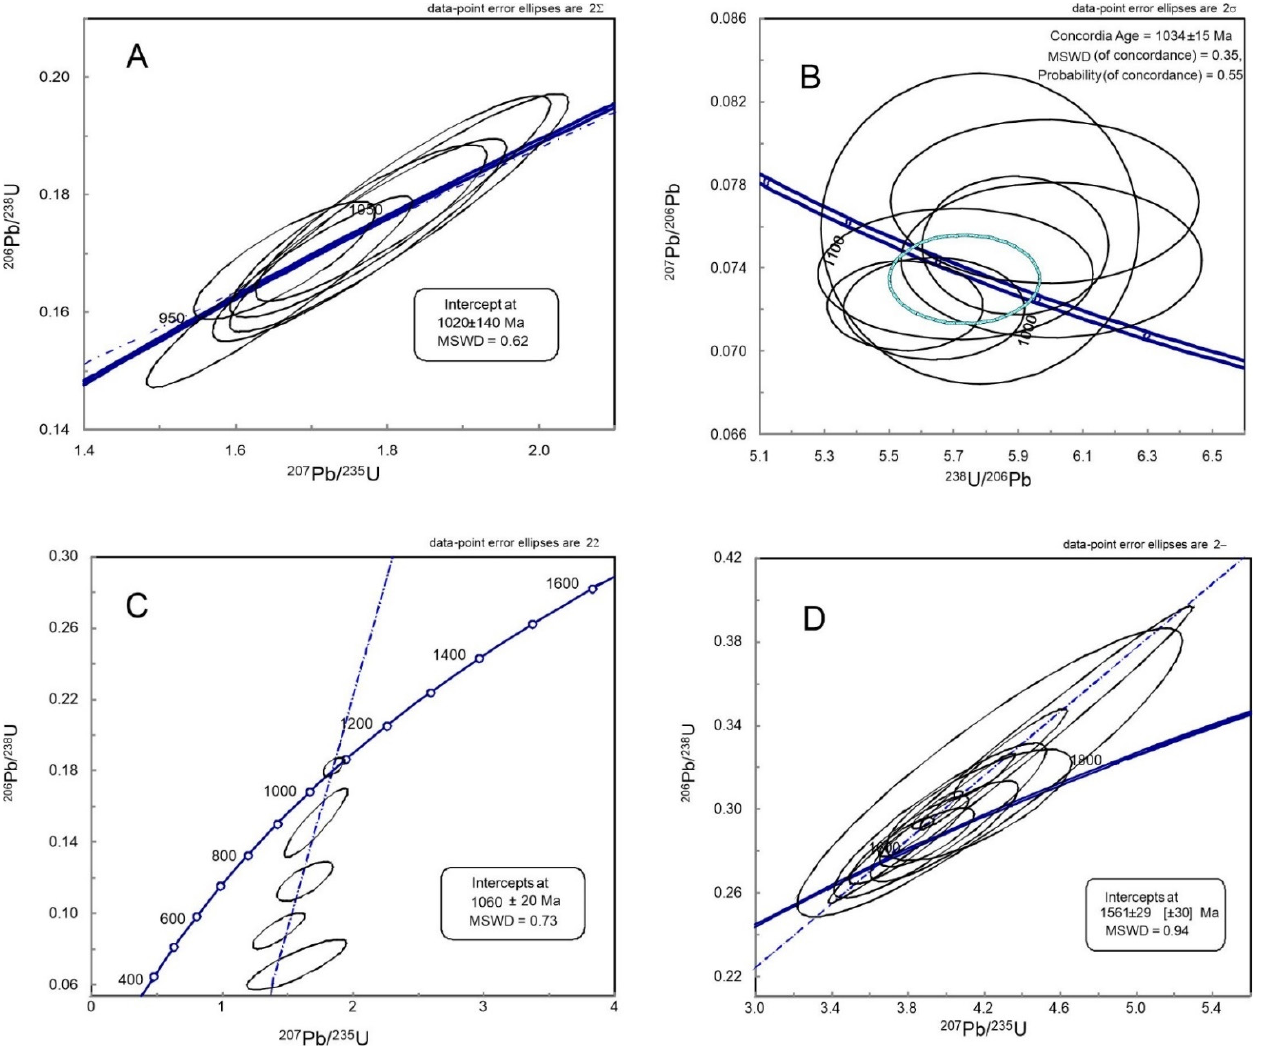
Figure 18. Concordia diagram of the analyzed samples in this investigation. ( A ) BD-MA-09B endogreisens sample collected at the São Domingos Facies in Massangana granite; ( B ) Concordia diagram of the representative sample of biotite-granite contained in the southeast portion of the Massangana Massif. The age obtained was 1060 ± 35 Ma; ( C ) Concordia diagram for BD-MA-13 endogreisens sample collected at the São Domingos Facies in Massangana granite; ( D ) Concordia diagram of the representative sample of gneiss from Serra da Providência suite. The obtained age, interpreted as the age of crystallization, is 1534 ± 15 Ma.